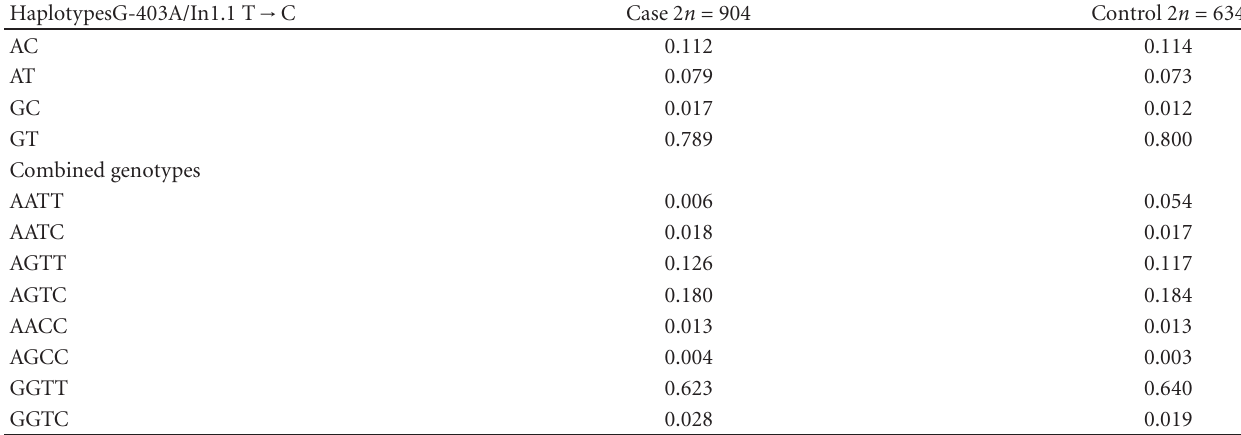
Table 5: The frequencies of haplotypes (estimated) and combined genotypes of two RANTES single nucleotide polymorphisms G-403A and In 1.1 T/C in the Slavonic